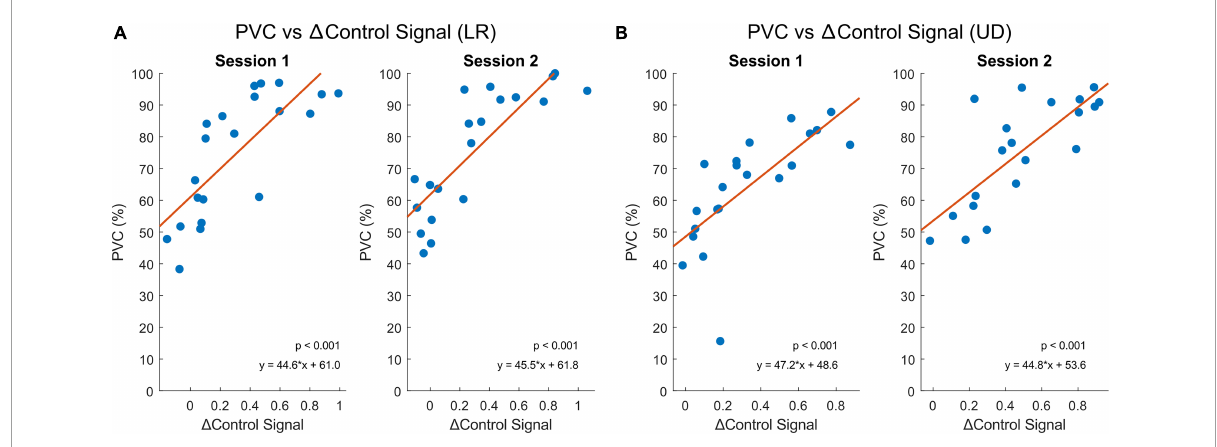
FIGURE5 The relationship between (cid:52) control signal and BCI performance (PVC, %) from both sessions using Spearman’s correlation. Session 1 contains subjects from group MC ( n = 10) and group CM ( n = 11) and session 2 contains subjects from group MM ( n = 10) and group MC ( n = 10). Blue dots represent each subject and orange lines represent the linear regression models of the individual points. (A) BCI performance correlates significantly with the (cid:52) control signal between the left and right trials ( p < 0.001). (B) BCI performance correlates significantly with the (cid:52) control signal between the up and down trials ( p <